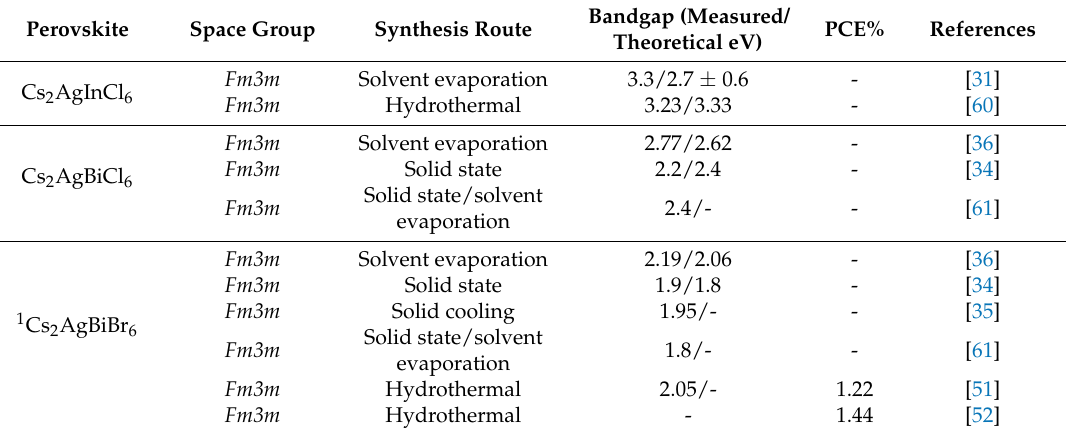
Table 3. Summary of some of the studied halide double perovskites showing space group, synthesis techniques, and bandgaps.